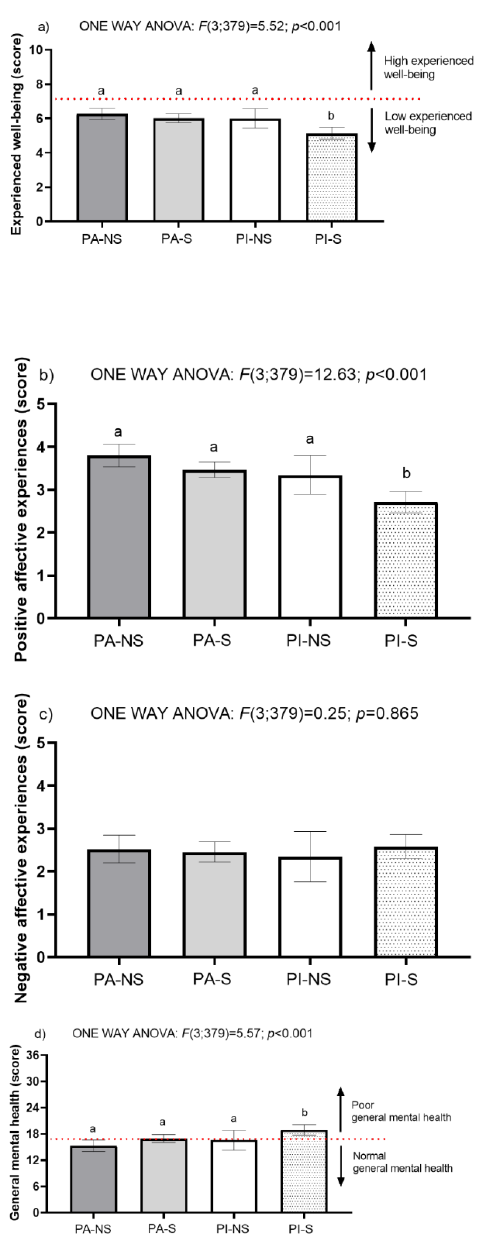
Figure 1. Subjective well-being and general mental health variables according to the physical activity behavioral profile and sedentary time. ( a ) Experienced well-being according to physical activity behavioral and sedentary time, ( b ) Positive affective experience according to physical activity behav- ioral and sedentary time, ( c ) Negative affective experience according to physical activity behavioral and sedentary time, and ( d ) General mental health according to physical activity behavioral and sedentary time. Note: PA-NS = physically active and non-sedentary, n = 84; PA-S = physically active and sedentary, n = 172; PI-NS = physically inactive and non-sedentary, n = 29; PI-S = physically inactive and sedentary, n = 97. Scores of six or less indicate low experienced well-being, and scores of seven or more indicate high experienced well-being. Regarding the general mental health variable on the GHQ-12 scale, the higher the score, the worse general mental health, where scores equal to or less than sixteen can be considered normal and scores greater than sixteen can be considered high. Variables are presented as mean and their respective 95% confidence